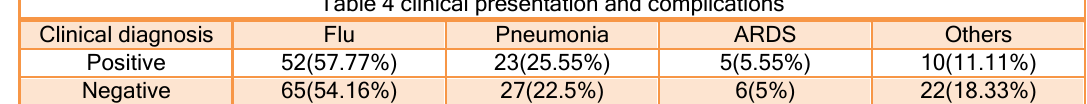
Table 4 clinical presentation and complications